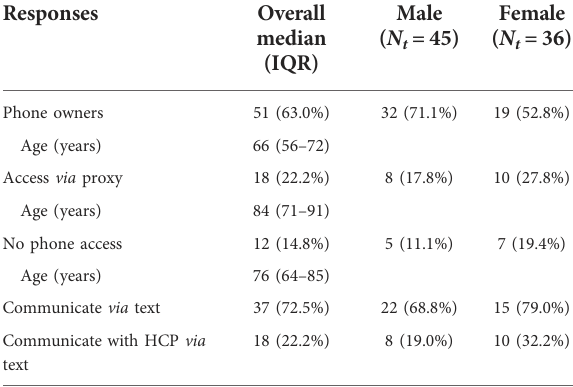
TABLE 4 Distribution of gender and age of survey participants by phone ownership/access.